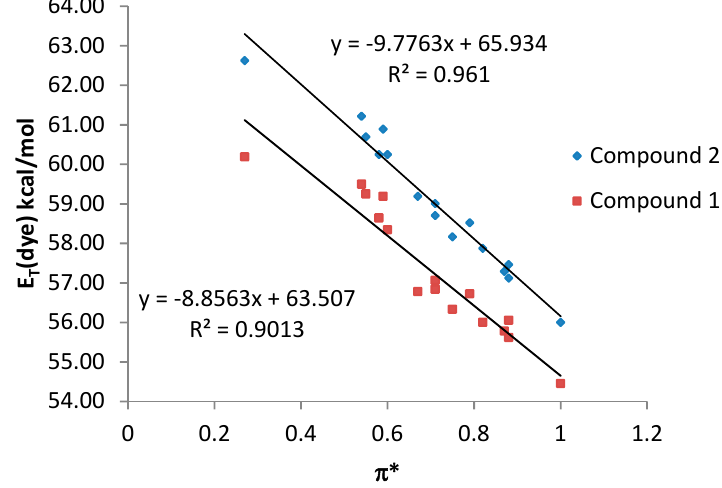
Figure 6. E T (dye) values (kcal · mol − 1 ) for compounds 1 and 2 vs. π * values for NHB and HBA solvents.